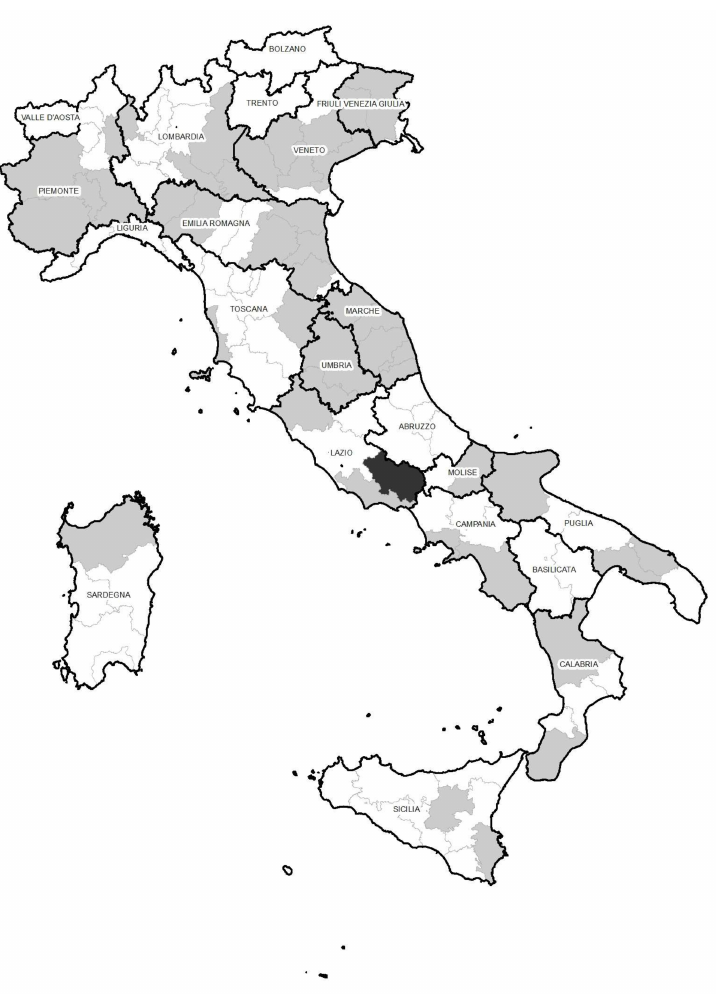
Figure 2. Sites (provinces) of farms where no residue (grey) and one residue (black) was detected during the